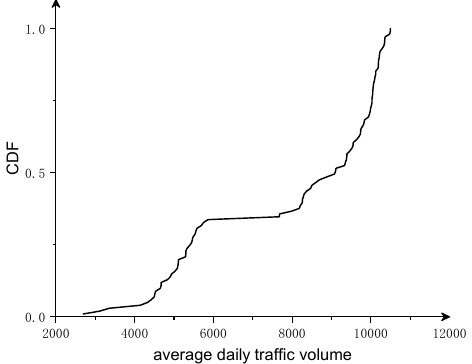
Figure 3. Cumulative distribution of average daily traffic volume.